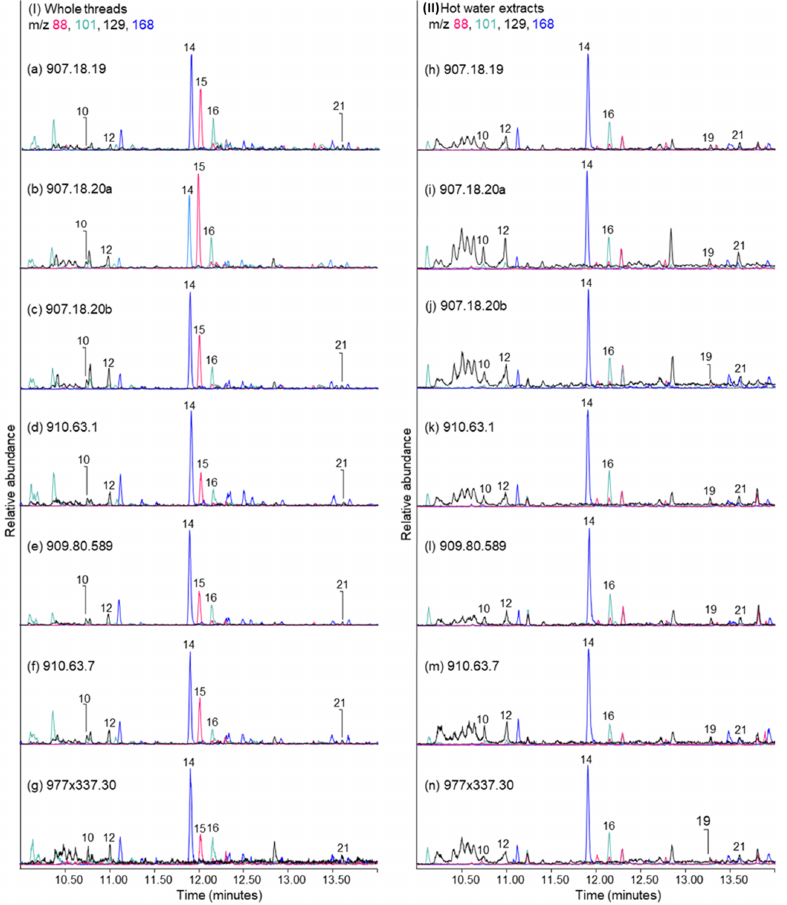
Figure 6. Partial extracted ion chromatograms ( m/z 88, 101, 129, 168) obtained by TMAH Py-GC-MS for whole threads from the pleated linen textiles ( left ), and for the hot water extracts of the threads ( right ). Peak labels correspond to compounds listed in Table 1.